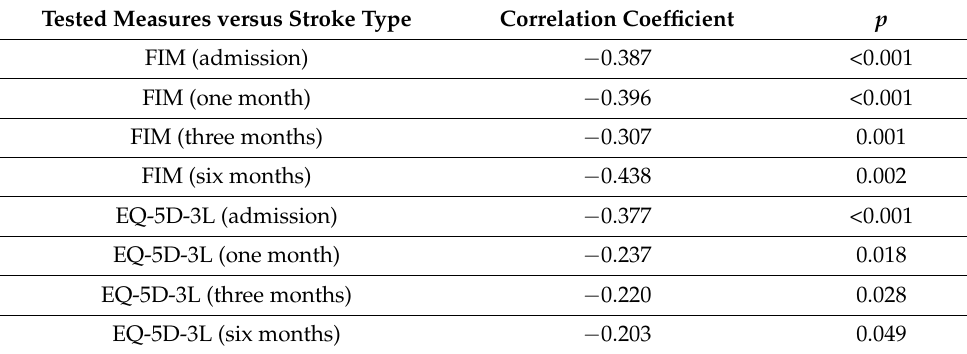
Table 4. Spearman correlation analysis between type of stroke and FIM, and type of stroke and EQ-5D-3L.